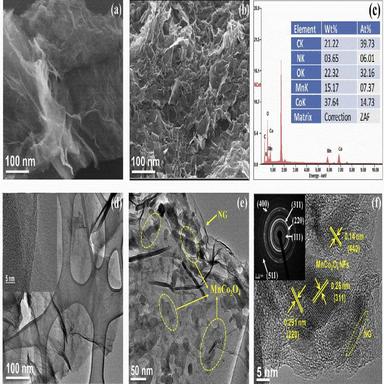
(a) FESEM image of NG, (b and c) FESEM images and EDAX spectrum of the MnCo2O4/NG 2D/2D hybrid nanoarchitectures, (d) TEM image of NG, (e and f) TEM, and HRTEM images, inset shows the SAED pattern of MnCo2O4/NG 2D/2D hybrid nanoarchitectures.